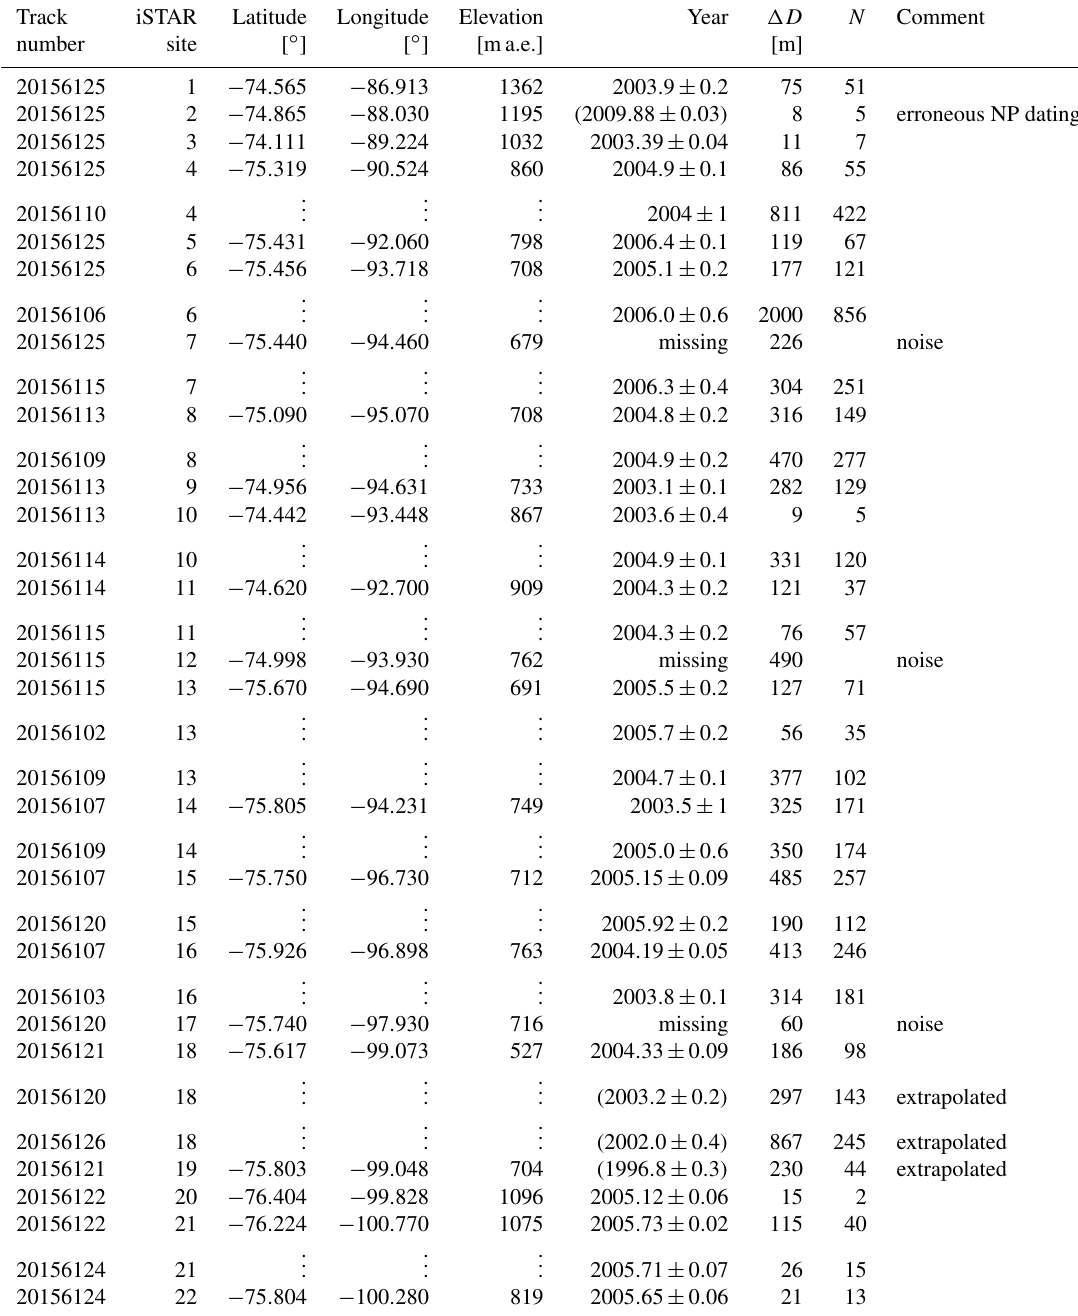
Table 2. Dated reflection layer year at nearby iSTAR sites. “Track number” refers to the ASIRAS flight track naming convention (year of measurement season (four digits), measurement type (one digit), profile segment number (three digits)); iSTAR site elevation in metres above ellipsoid (ma.e.) with respect to the ITRF08(2015) reference framework; (cid:49)D is the closest distance between the ASIRAS track and iSTAR site, and N is the number of picking samples considered for layer dating. Years in brackets are discarded from the regional layer age estimation due to (i) significant departure between traced layer and depth–age scale at site 2 (see main text), (ii) layer gaps due to high noise levels in the radargram, and (iii) the layer significantly exceeding the dated NP profile depth (values in brackets indicate extrapolated depth–age